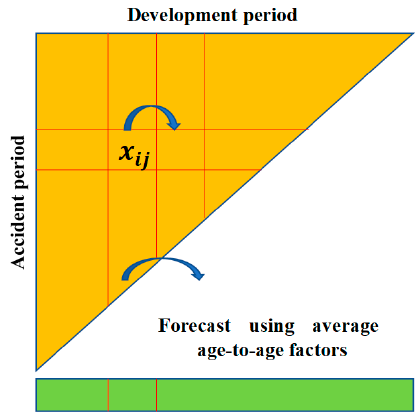
Figure 2. Illustration of a forecast by age-to-age factors.